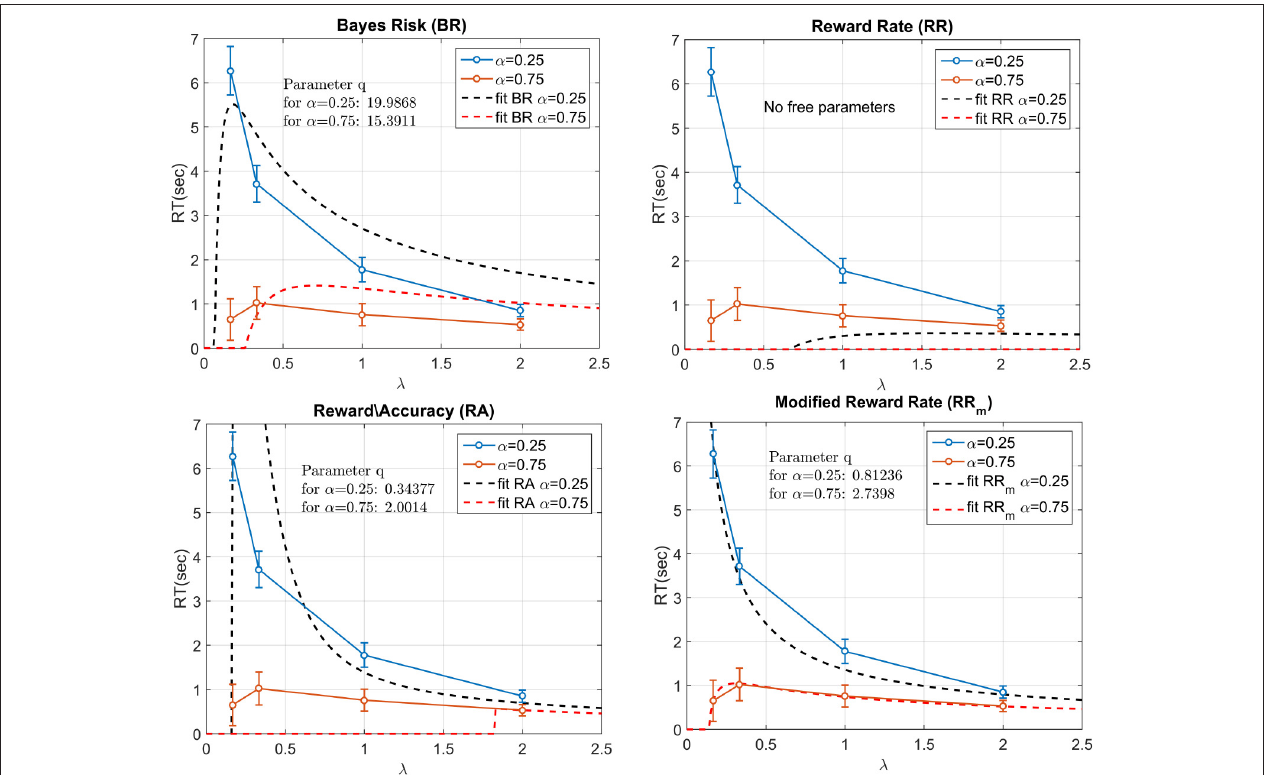
FIGURE 6 | Fitting the four decision rules to the data by minimizing the least squares. RR does not have any free parameter, whereas for the other decision rules the free parameter q had to be estimated. In the figure, the parameter q is allowed to vary across the two α conditions. The best fit was provided by RR m . The two estimated q values were largely different between the two α conditions.